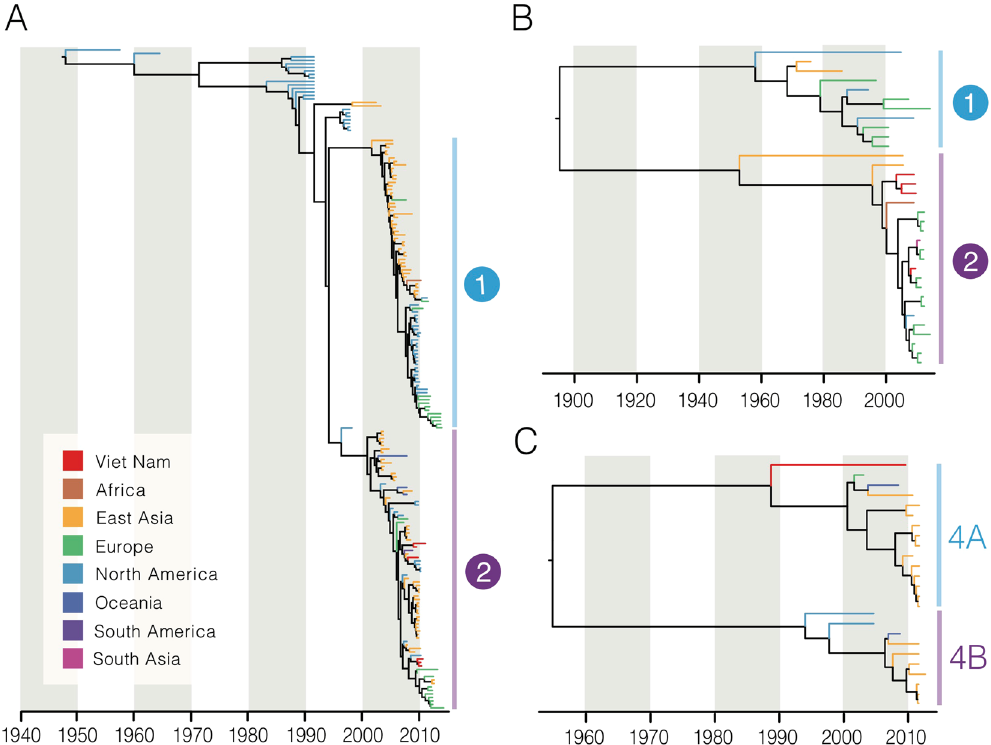
Figure 1. Dated trees of the HN gene of HPIV1 ( A ), HPIV2 ( B ), and HPIV4 ( C ); terminal branches are colored by geographical region of virus isolation. ( A ) HPIV1 global phylogeny. Clades 1 and 2 correspond to clusters identified previously in the literature. ( B ) HPIV2 phylogeny. Representative clades are labelled for discussion purposes. ( C ) The HPIV4 phylogeny comprises two clades corresponding to previously described subspecies 4A and